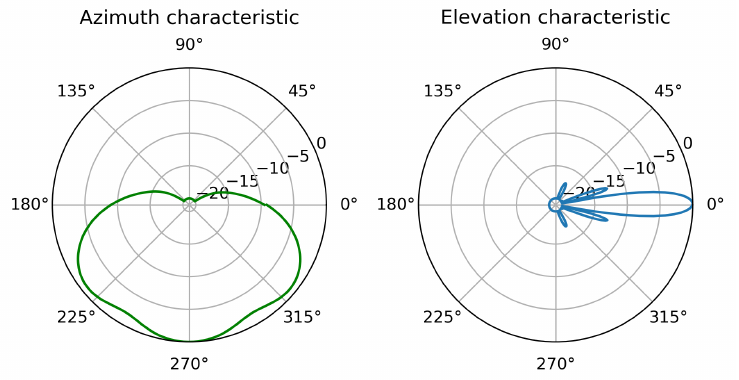
Figure 3. Mikrotik mANT19s antenna directional characteristics based on measurements provided by the manufacturer.